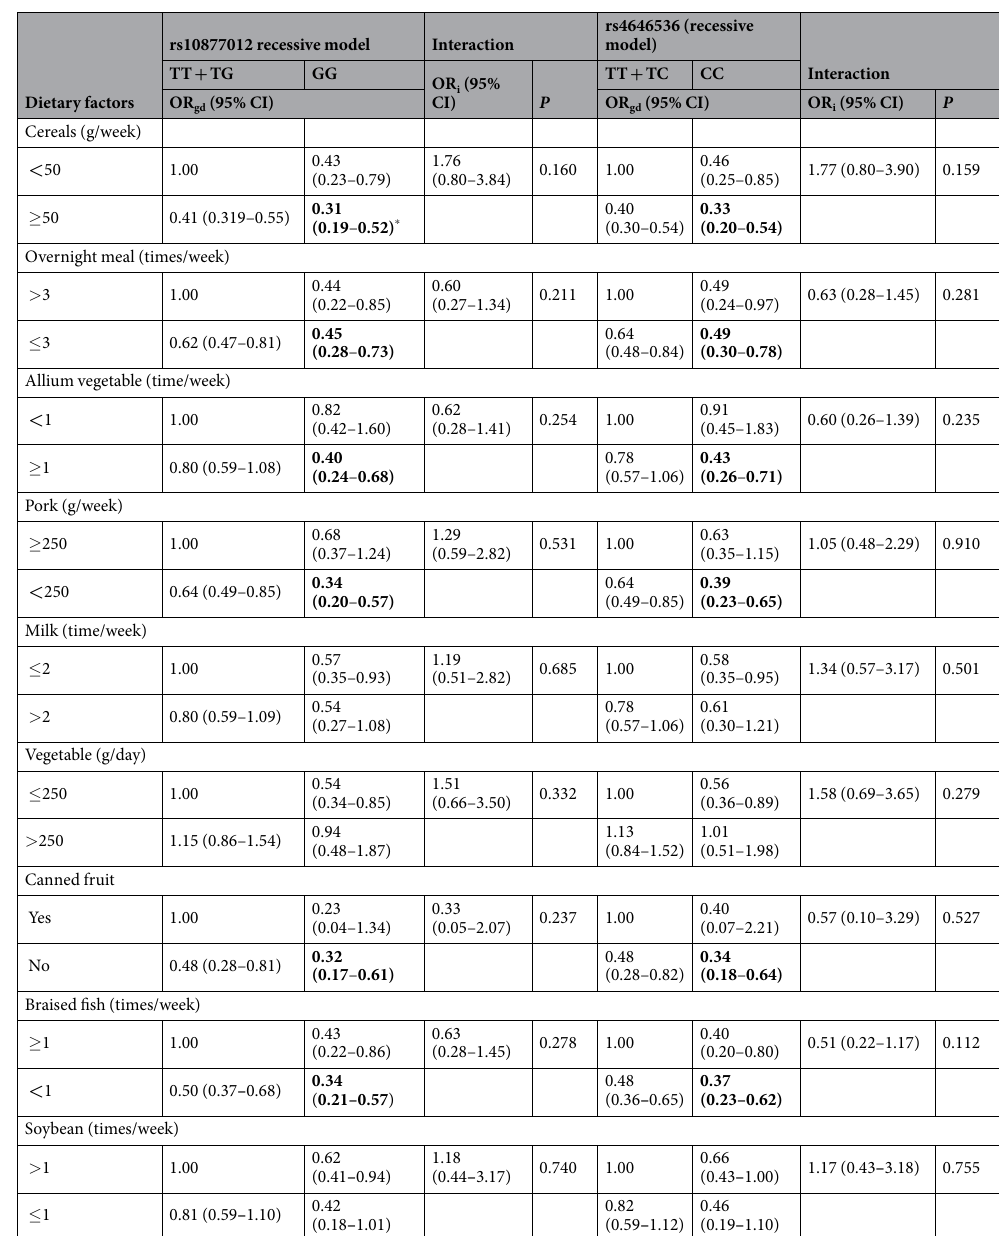
Table 5. Combined and interactive effects between polymorphisms in CYP27B1 and dietary factors in CRC. OR gd : OR genetic&dietary , combined effects of polymorphisms and dietary factors. OR i : OR interaction , interactive effects of polymorphisms and dietary factors. Note, we analyzed the combined effects for nine dietary factors and four polymorphisms of CYP24A1 and CYP27B1, the P value after Bonferroni correction is 0.05/36 = 0.0014. We analyzed the interactive effects using logistic regression, the significant P value of interactive effect is 0.05. * Bold values indicate significance after Bonferroni